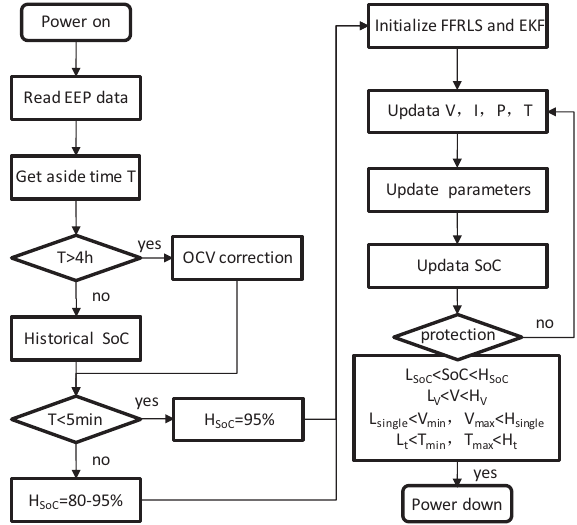
Figure 8. The flow chart of the battery management system. The power on and the charging are performed by manual operation, and normal protection and power down are controlled by the